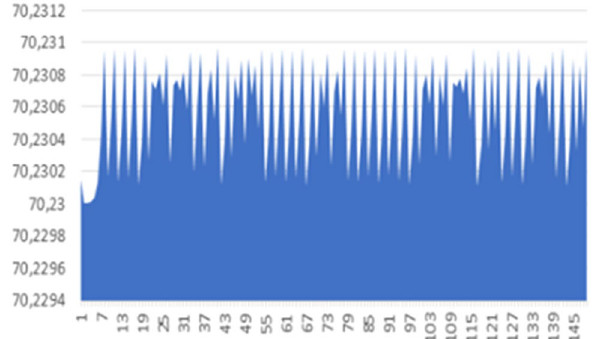
Fig. 14 NPCR distribution